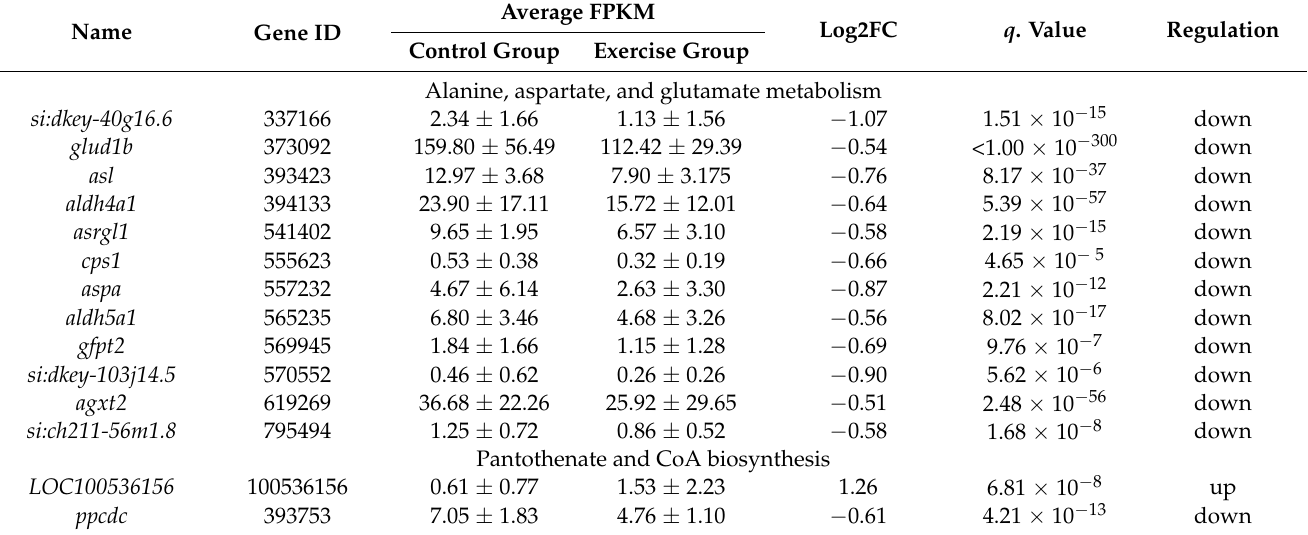
Table 2. The 35 genes coenriched with differential metabolites in identified metabolic